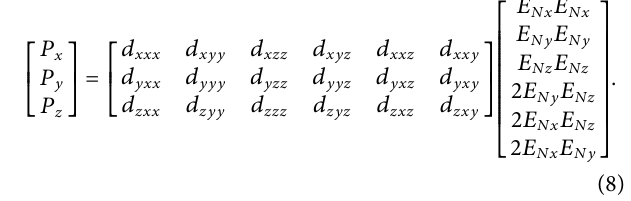
Frontiers in Chemistry |